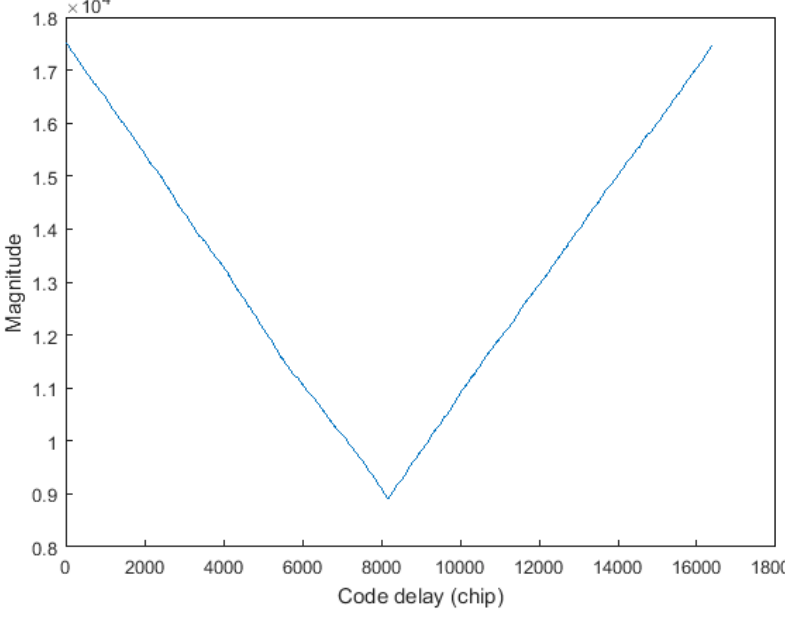
Figure 5. Zero-padding leads to the autocorrelation attenuation.